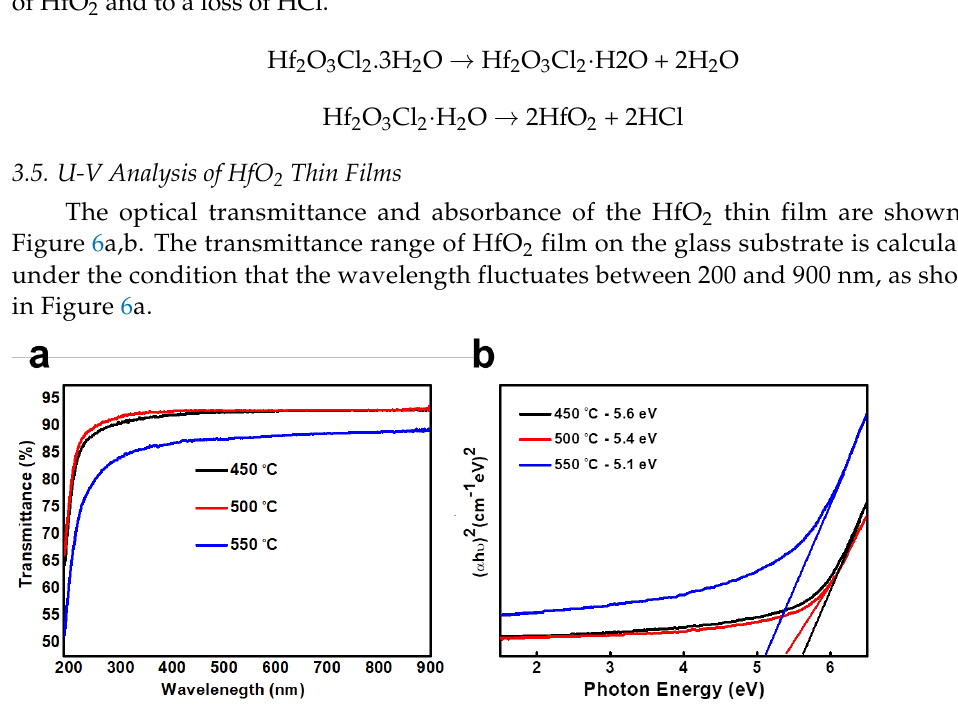
Figure 6. ( a ) Optical transmittances of WI HfO 2 thin films annealed at different temperatures; ( b ) bandgap of WI HfO 2 thin films annealed at different temperatures.